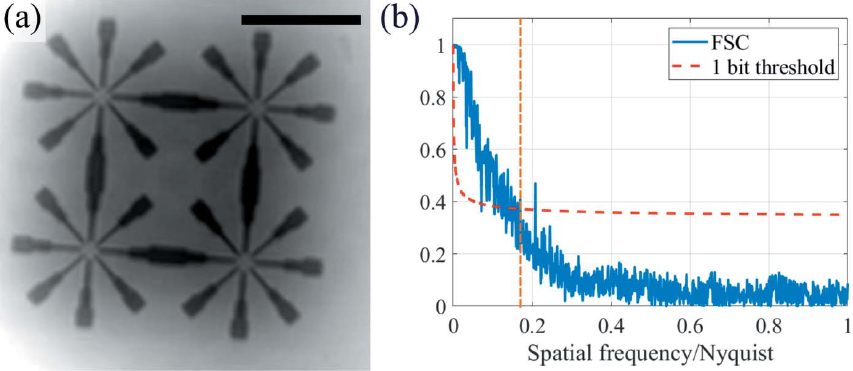
Figure 5 2D test pattern reconstructions ( a ) and resolution evaluation using Fourier ring correlation ( b ). The vertical orange-dashed line in ( b ) represents the focal-spot resolution limit. The scale bar corresponds to 4 m m, and the resolution estimated by the 1-bit threshold criterion is 79 nm.